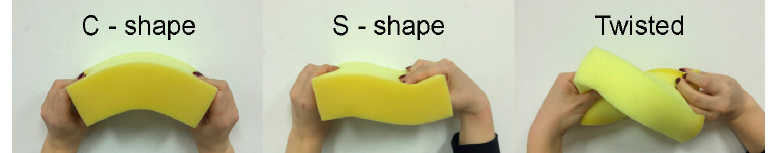
Figure 4. A macroscopic example in which a sponge is deformed by hand, illustrating the relationship between the rotational force and shape. The sponge can be bent in two different ways (left and middle) and twisted (right).